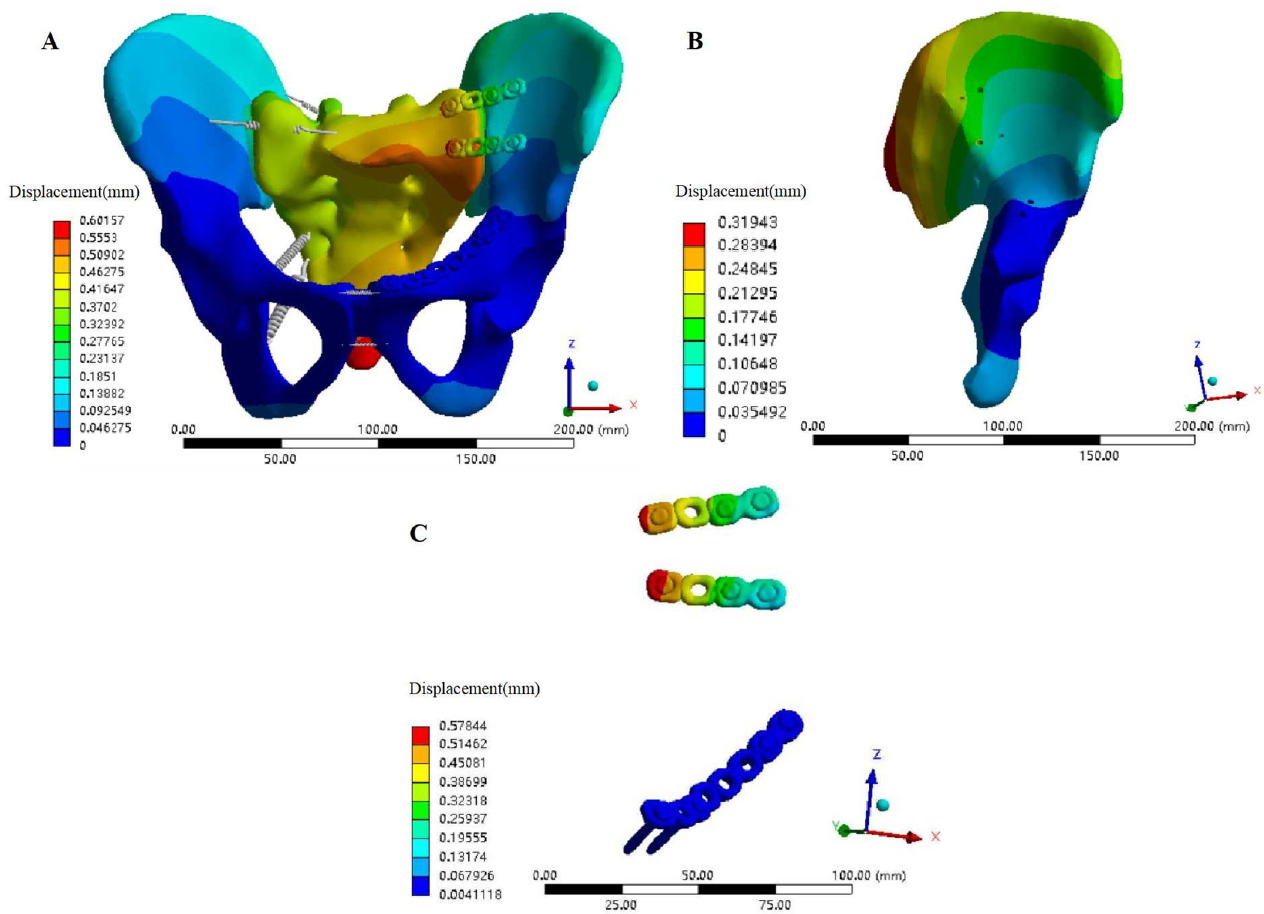
Fig 5. Displacement distribution of each component of the pelvis model fixed with steel plate. (A) Displacement distribution of the pelvis model fixed with steel plate under a vertical load. (B) Displacement distribution of the iliac bone of the pelvic model fixed with a steel plate under a vertical load. (C) Displacement distribution of the steel plate and screw of the pelvic model fixed by a steel plate under a vertical load.